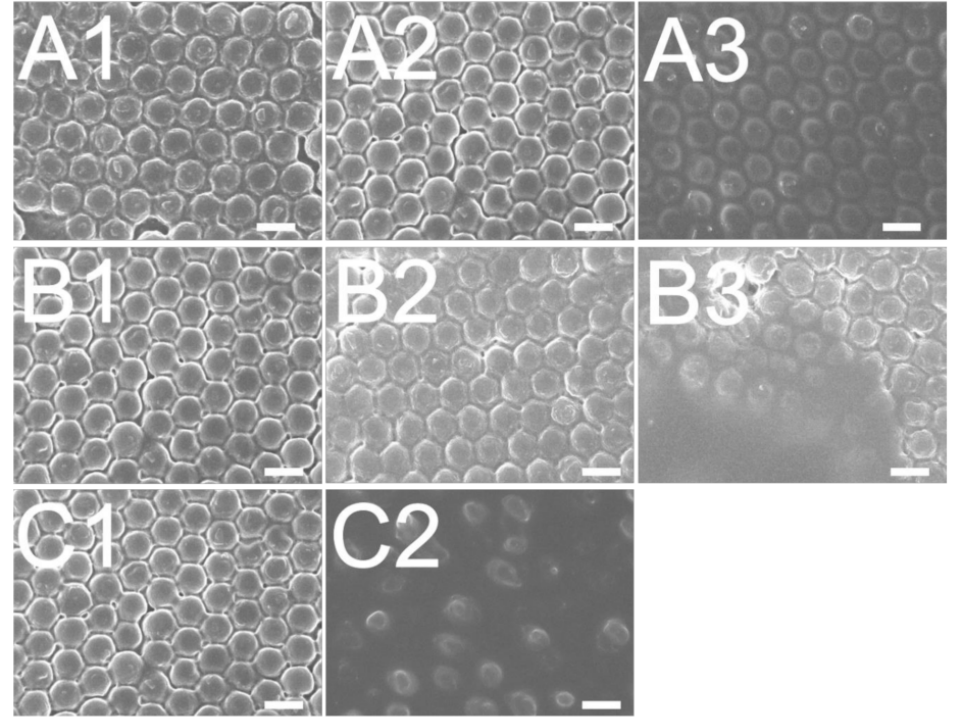
Figure 12. Effect of ( A ) roller stamp/glass substrate distance; ( A1 ): +100 µ m, ( A2 ): 0 µ m, ( A3 ): − 200 µ m, ( B ) rolling speed; B1 : 5.23 mm/s, ( B2 ): 13.08 mm/s, ( B3 ): 20.93 mm/s, ( C ) UV dose; ( C1 ): 3900 mW/cm 2 , ( C2 ): 530 mW/cm 2 , on the fabrication of 900 nm nanofeatured